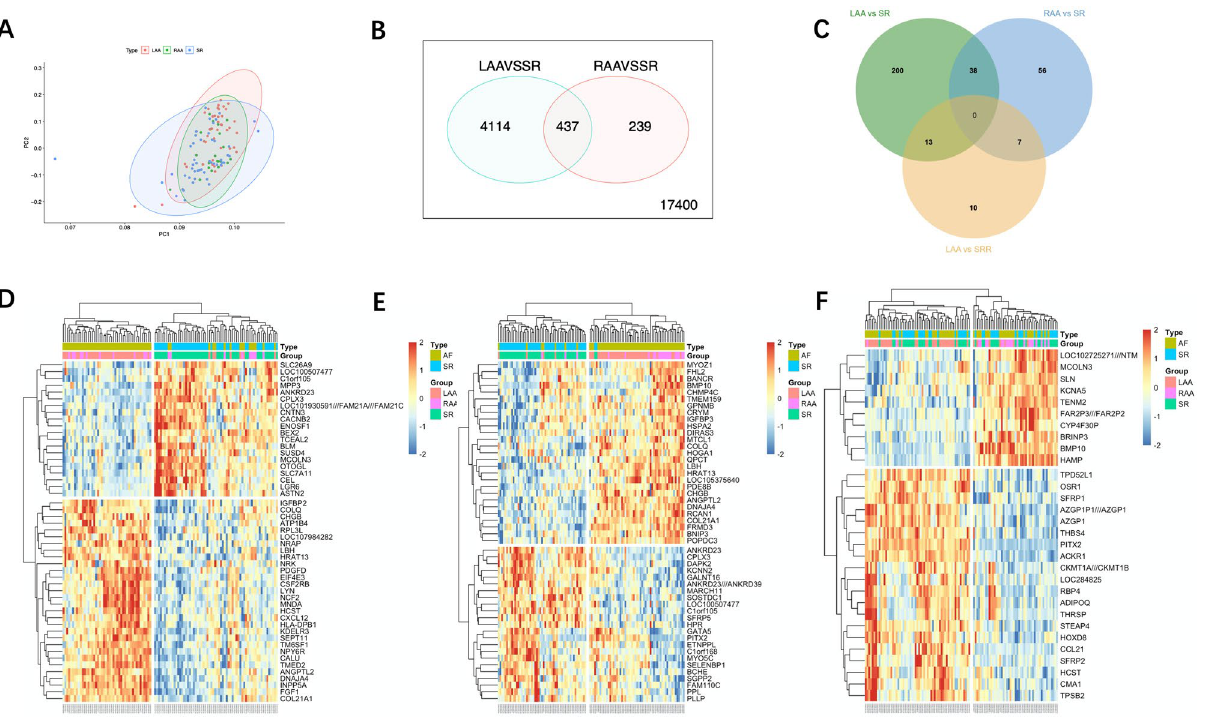
Figure 3. Principal component analysis and differential analysis of expressed genes. ( A ) Principal component analysis. ( B ) Venn plot of two contrast matrices (LAA vs. SR, RAA vs. SR). The numbers shown in circles are the adjusted P value < 0.05. ( C ) Venn plot of DEGs of three contrast matrices (LAA vs. SR, RAA vs. SR, and LAA vs. RAA). ( D – F ) Heatmap of DEGs (‘pheartmap’ package). ( D ) LAA vs. SR. ( E ) RAA vs. SR. ( F ) LAA vs.